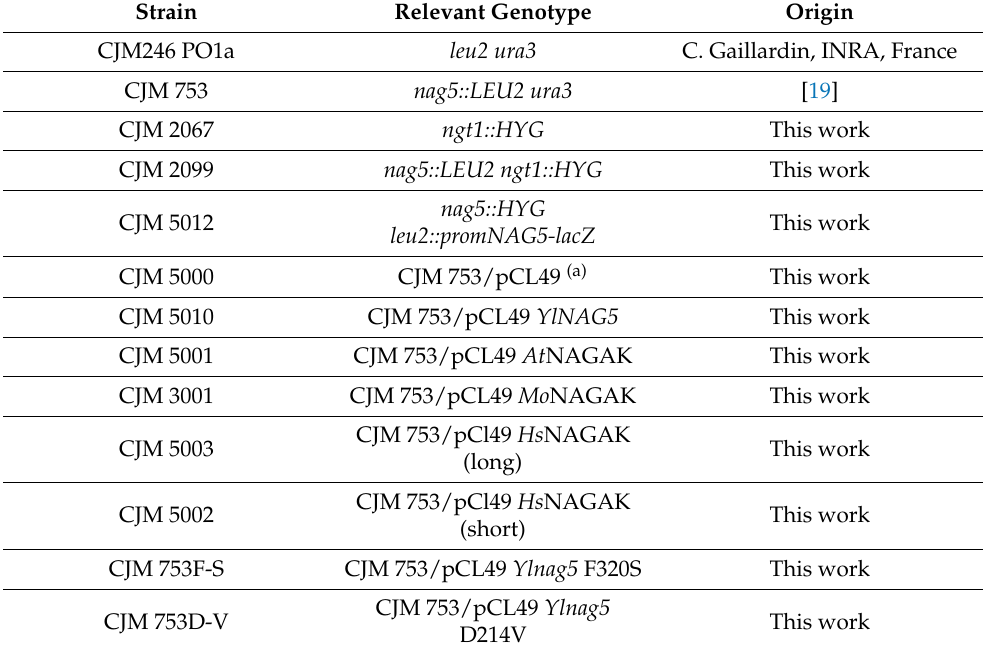
Table 3. Y. lipolytica strains used in this